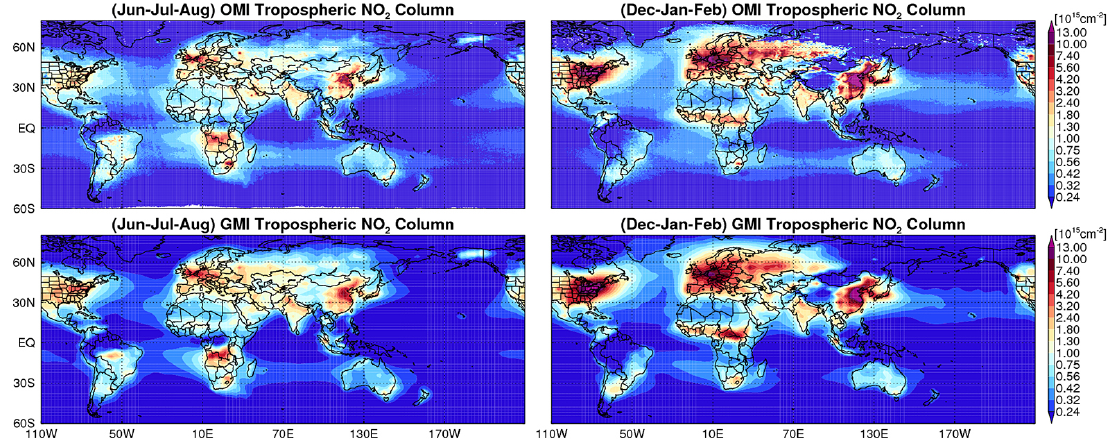
Figure C3. For June–August (left column) and December–February (right column) averages over 2005–2007; top: OMI tropospheric column NO 2 ; bottom: GMI tropospheric column NO 2 .